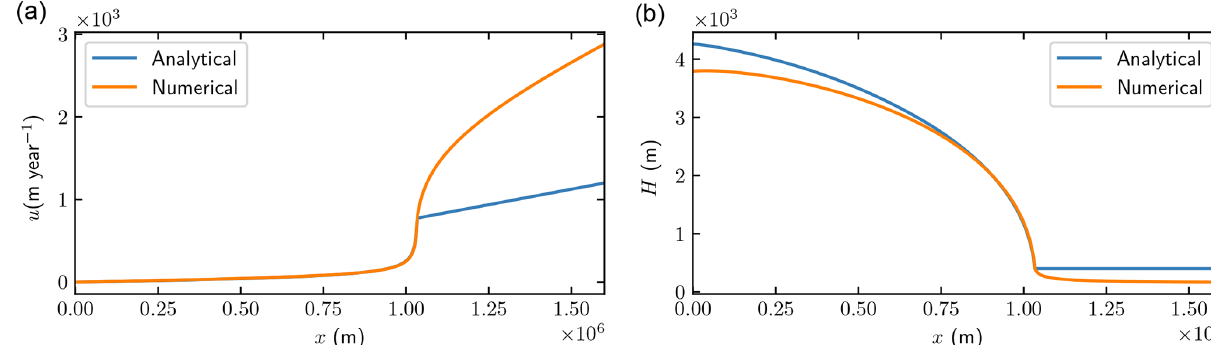
Figure 5. Comparison of the steady-state numerical solutions of the SSA velocity u and the thickness H in Eq. (17) (orange) and the analytical solutions in Eq. (A1) (blue).